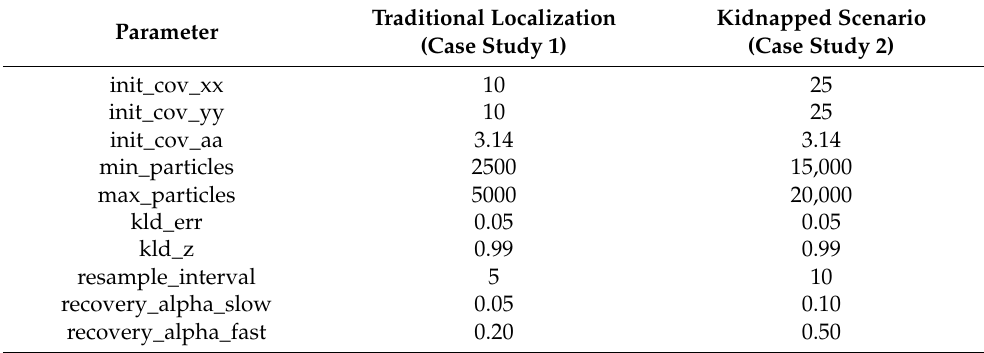
Figure 10. ( a ) Navigation path for traditional localization and ( b ) robot locations for kidnapped localization. Table 1. Modifications to the AMCL default parameters for the kidnapped robot problem.